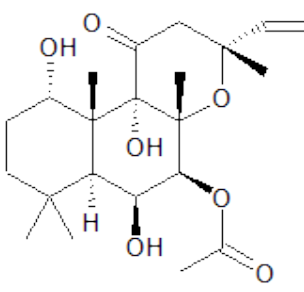
Figure 5. Forskolin, a labdane diterpene produced by the plant Plectranthus barbatus activates the membrane bound enzyme adenylate cyclase and increases intracellular levels of cAMP.